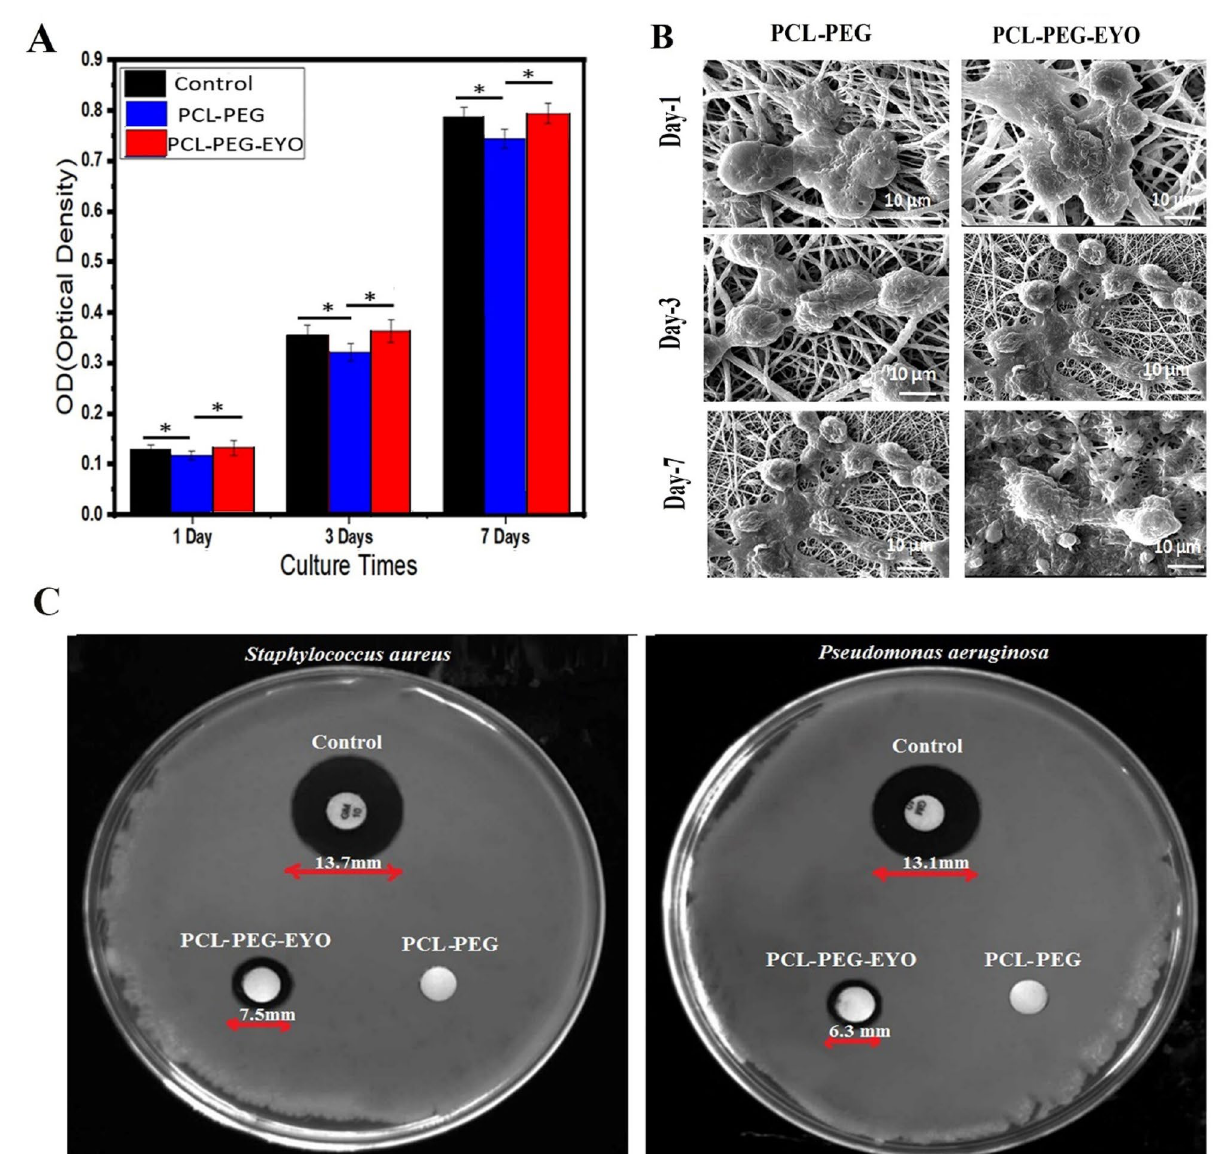
Figure 4. ( A ) MTT assay; ( B ) SEM micrograph of L929 cells cultured on PCL-PEG and PCL-PEG-EYO nanofibrous scaffold after 1, 3 and 7 day(s); *P-value < 0.05; ( C ) Antibacterial activity of ( A ) PCL-PEG-EYO web, ( B ) PCL-PEG web and ( C ) Control ( Gentamicin 10 mg ) against Staphylococcus aureus as a gram positive bacteria and Pseudomonas aeruginosa as a gram negative